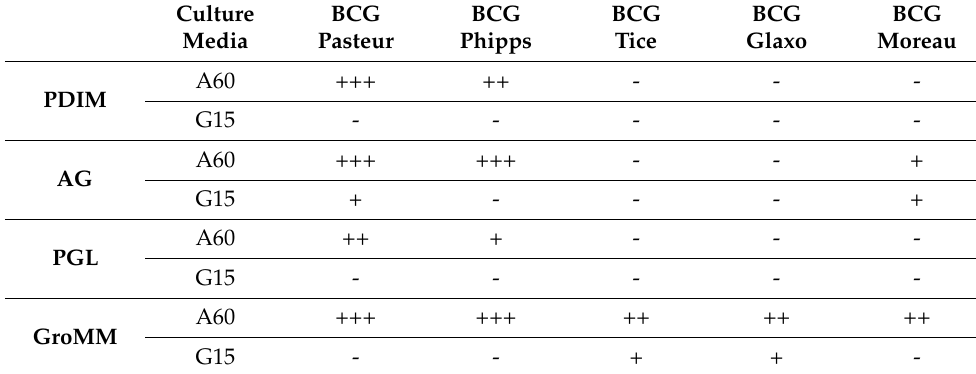
Table 1. Superficial lipidic pattern of BCG substrains (Pasteur, Phipps, Tice, Glaxo, and Moreau) grown on two different Sauton compositions (A60 and G15) that differ by amino acid source, L- asparagine (A) or L-glutamate (G), and the glycerol concentration, 60 mL/L (60) or 15 mL/L (15). PDIM: phthiocerol dimycocerosate; AG: acylglycerol; PGL: phenolic glycolipid; GroMM: glycerol monomycolate. +, present; ++, highly present; +++, abundantly present; -, not present.